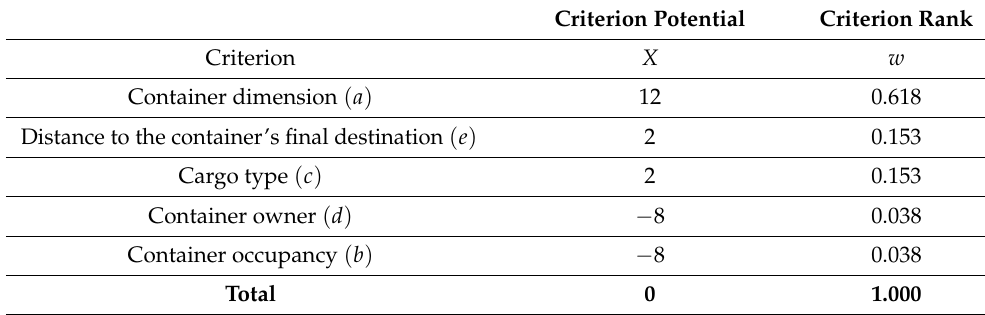
Table 4. Criterion potentials and ranks based on the consistent approximation preference stream.